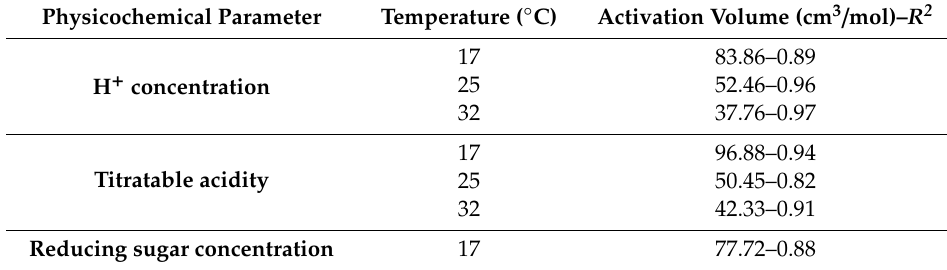
Table 2. Activation volumes (cm 3 / mol) of each physicochemical parameter analyzed for fermentation at 17, 25, and 32 ◦